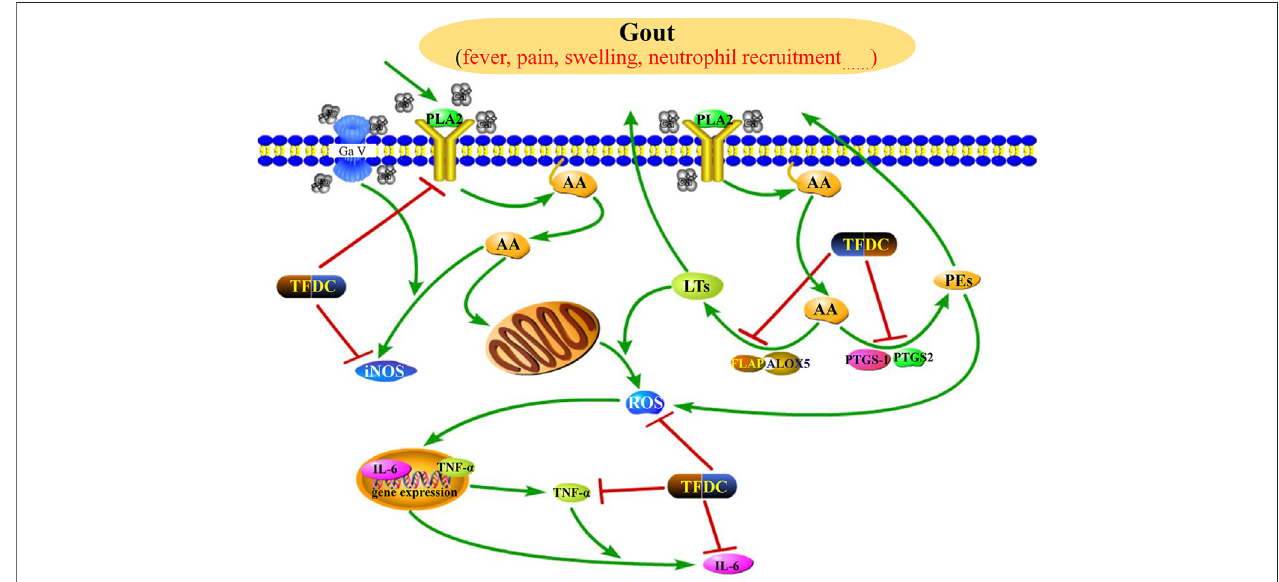
FIGURE 7 | Illustration of the arachidonic acid metabolism pathway in fl uenced by the major putative targets of TFDC components. PLA2 , phospholipase A2; AA , arachidonic acid; LTs , leukotrienes; PGs , prostaglandins; iNOS , inducible NO synthase; ROS , reactive oxygen species; FLAP , 5-lipoxygenase-activating protein; ALOX5 , polyunsaturated fatty acid 5-lipoxygenase; PTGS1 , prostaglandin G/H synthase 1; PTGS2 , prostaglandin G/H synthase 2; TNF- α , tumor necrosis factor alpha; IL-6 , interleukin-6; TFDC , Tongfengding capsule.